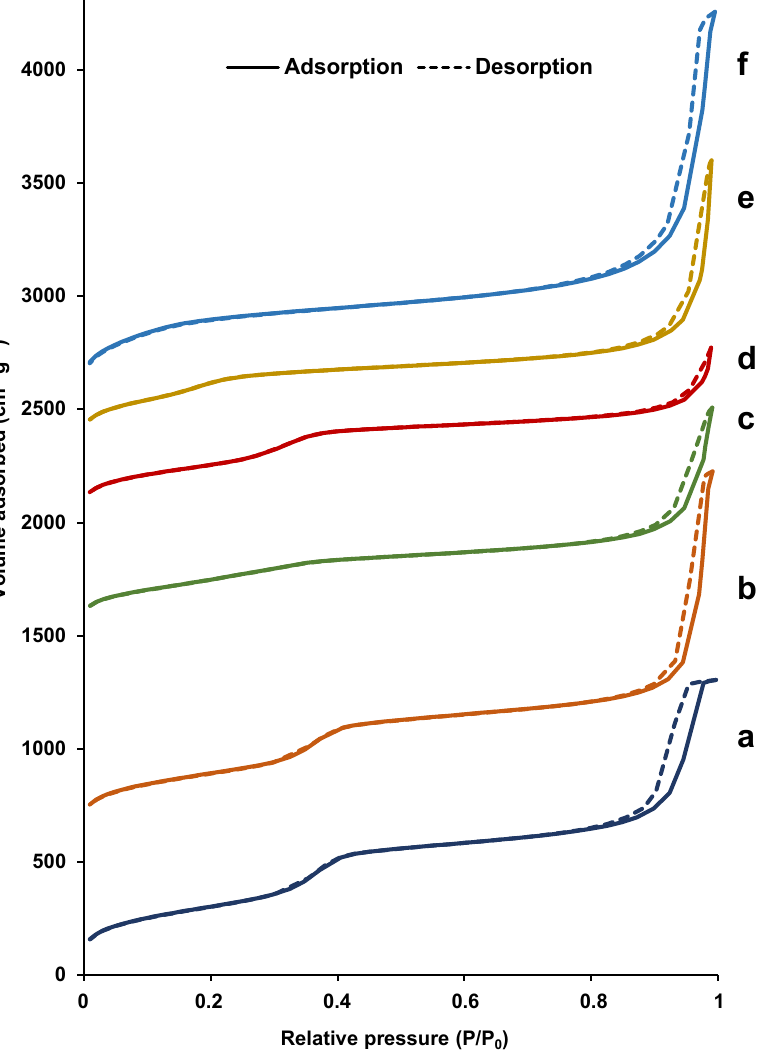
Figure 3. N 2 adsorption–desorption isotherms of the synthesized materials: (a) Fe100-UVM-7-C 16 , (b) Fe50-UVM-7-C 16 , (c) Fe25-UVM-7-C 16 , (d) Fe10-UVM-7-C 16 , (e) Fe50-UVM-7-C 12 , and (f) Fe50- UVM-7-C 10 .